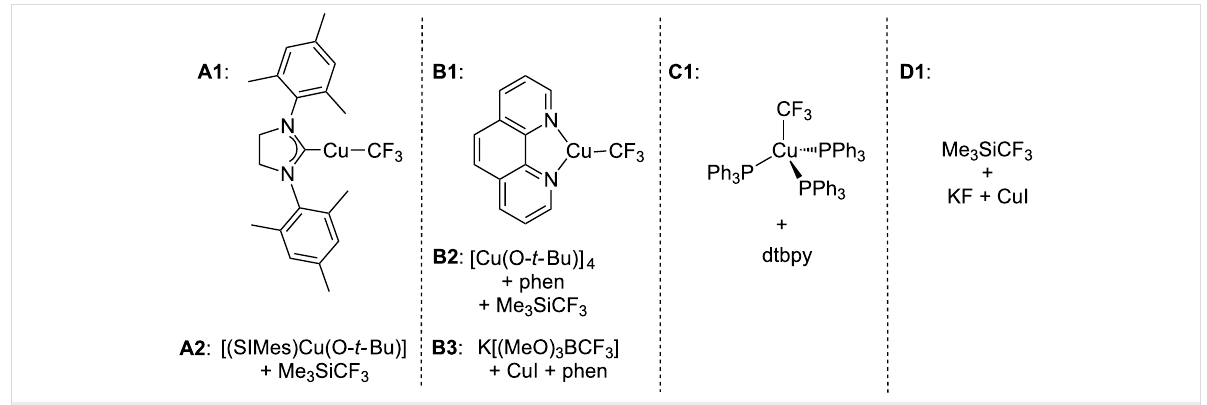
Scheme 1: Reagents and precursors used for trifluoromethylation reactions.